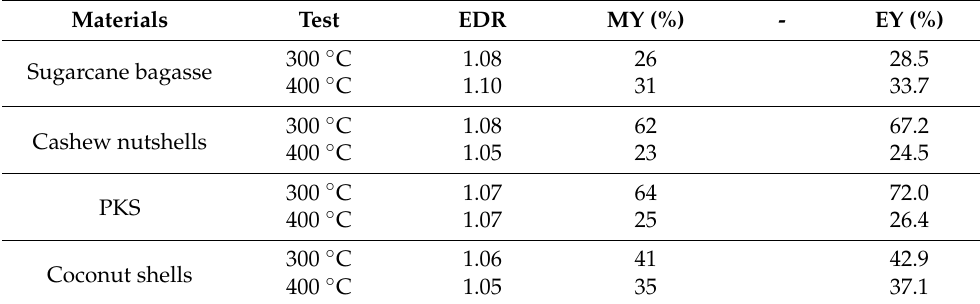
Table 6. Values calculated for EDR, MY, and